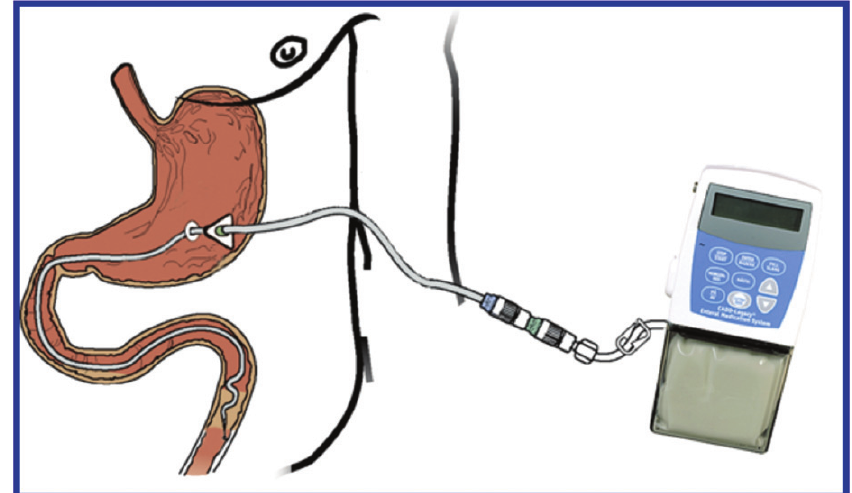
Figure 2. Infusion system for levodopa/carbidopa intestinal gel.